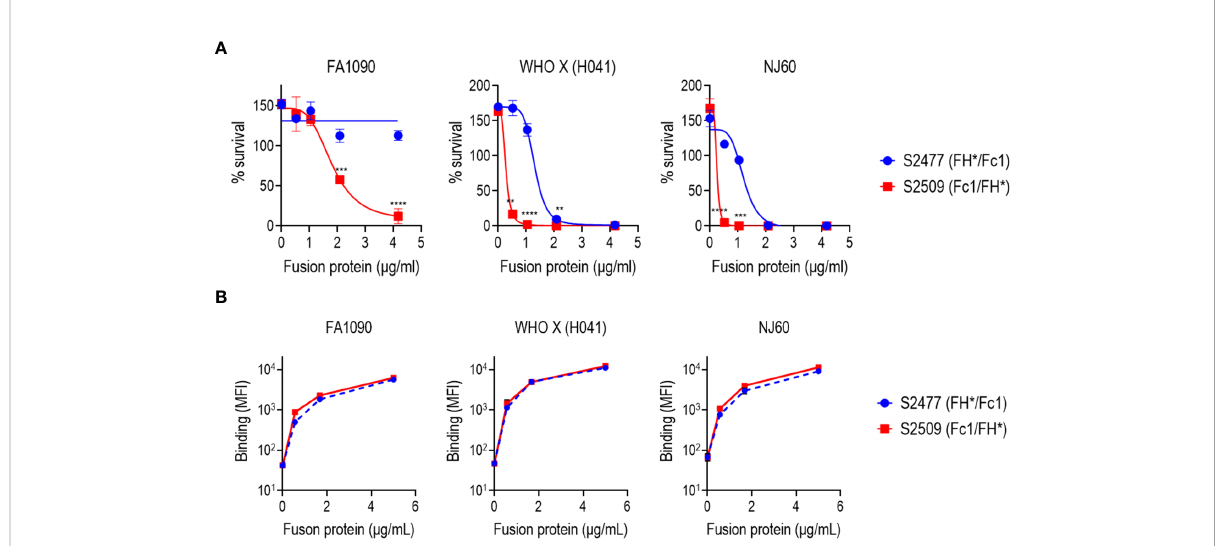
FIGURE 2 Bactericidal activity and binding of S2477 (FH*/Fc1) and S2509 (Fc1/FH*) produced in N. benthamiana against N. gonorrhoeae in vitro . (A) Serum bactericidal activity of S2477 (FH*/Fc1) and S2509 (Fc1/FH*). The proteins were incubated (concentrations indicated in the X-axis) with N. gonorrhoeae strains FA1090, WHO X (H041) and NJ60 and 20% human complement. Survival of bacteria following incubation for 30 min relative to CFU at 0 min is expressed as a percentage on the Y-axis. The mean (SEM) of 4 separate experiments is shown. The best- fi t curve used to generate the IC50 is shown. Two-way ANOVA was used to measure differences in killing across the two molecules at each concentration. **P<0.01; ***P<0.001; ****P<0.0001. (B) Binding of S2477 (FH*/Fc1) and S2509 (Fc1/FH*) to N. gonorrhoeae . The fusion proteins (concentrations indicated on the X-axis) to N. gonorrhoeae FA1090, H041 and NJ60 was measured by fl ow cytometry. The median fl uorescence intensity (MFI) is indicated on the Y-axis. The mean (range) of two separate experiments is